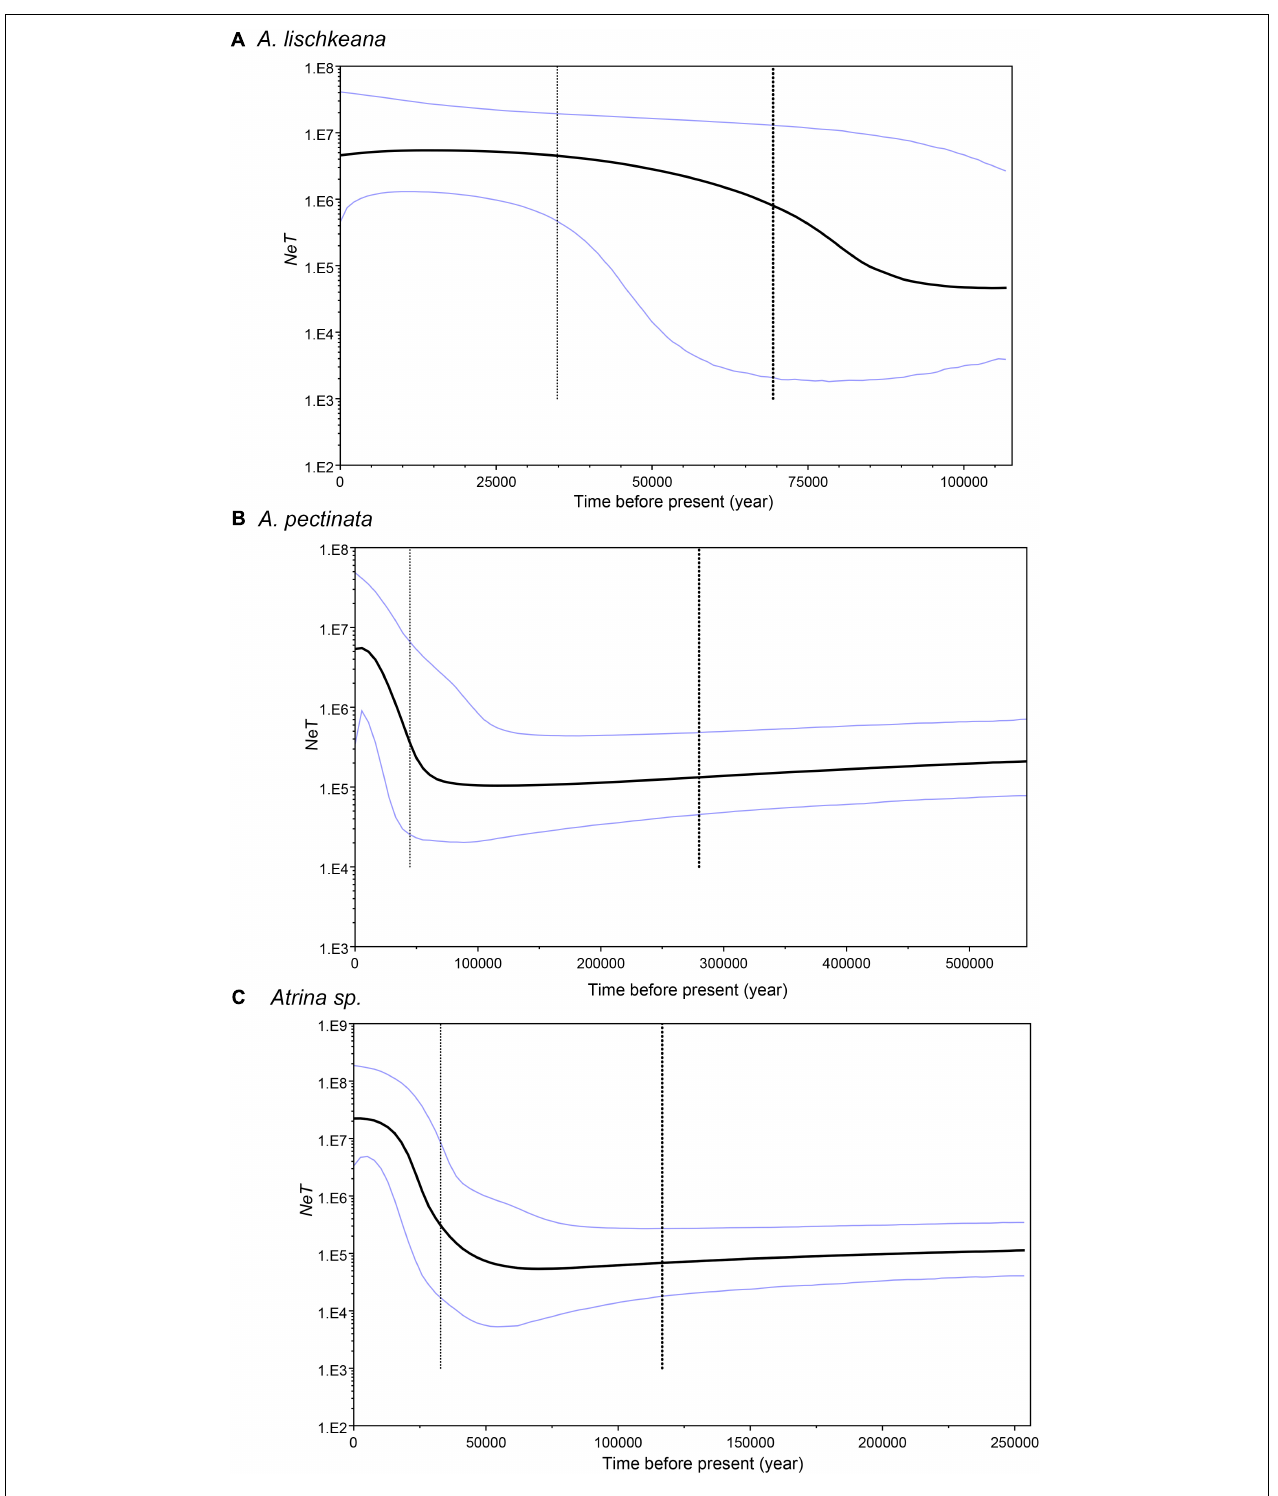
FIGURE 7 | Demographic history of (A) A. lischkeana , (B) A. pectinata, and (C) Atrina sp. estimated using Bayesian skyline plots from mt COI sequences. The figure shows changes in NeT ( Ne , effective population size; T , generation time) over time. The black lines represent median estimates of NeT ; the light lines are the upper and lower 95% highest posterior density (HPD) limits of NeT ; and the vertical light dashed line represents the median estimates of the time to the most recent common ancestor (TMRCA). The upper 95% HPD on TMRCA is shown at the right of the plot, whereas the lower 95% HPD is the black dashed line to the left of the median. The y -axis is plotted on a logarithmic